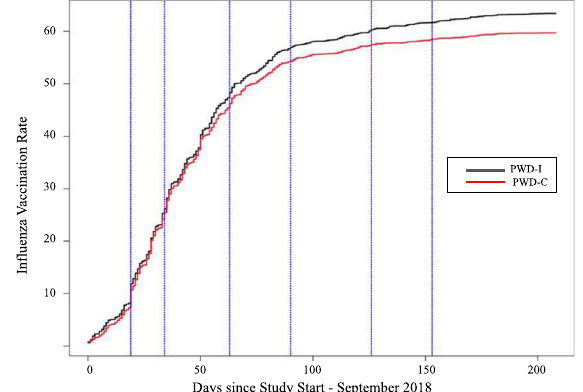
Fig. 4 Time to vaccination in the PWD-I group compared to the PWD-C group. Depicts the vaccination rate over the course of the study using a Kaplan – Meier curve. PWD-I People with diabetes- intervention group; PWD-C People with diabetes-Control group.